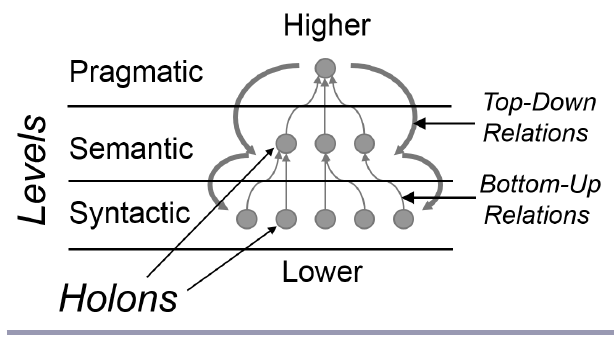
Fig. 2 . Graphical illustration of holonic relations and information